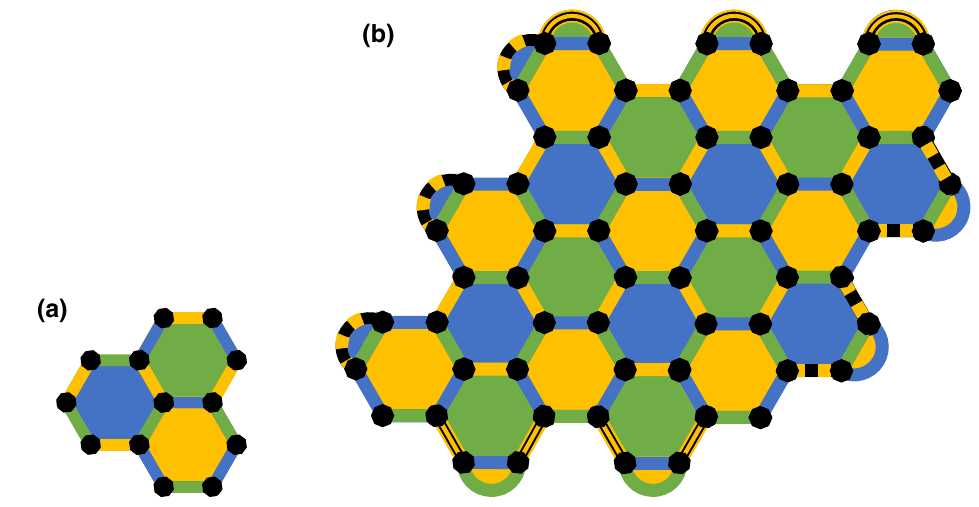
FIG. 1. (a) The tiling unit for the honeycomb code. Qubits are indicated by black dots. We assign a check operator ZZ for each horizontal edge, XX for each edge with positive slope, and YY for each edge with negative slope. (b) The parallelogram boundary con- ditions for the honeycomb code. The solid-color edges are measured in a period-6 sequence (yellow, blue, green, yellow, green, blue). The curved edges are Pauli operators, chosen such that the triple of check operators meeting at a vertex are pairwise anticommuting. (The degree-4 vertex in the top left corner is treated specially; see Table I.) For example, the curved green edges along the bottom are assigned XY operators (from left to right). The striped black-yellow edges, bordering green faces, are measured during the first yellow round, while the dashed black-yellow edges, bordering blue faces, are measured during the second yellow round.